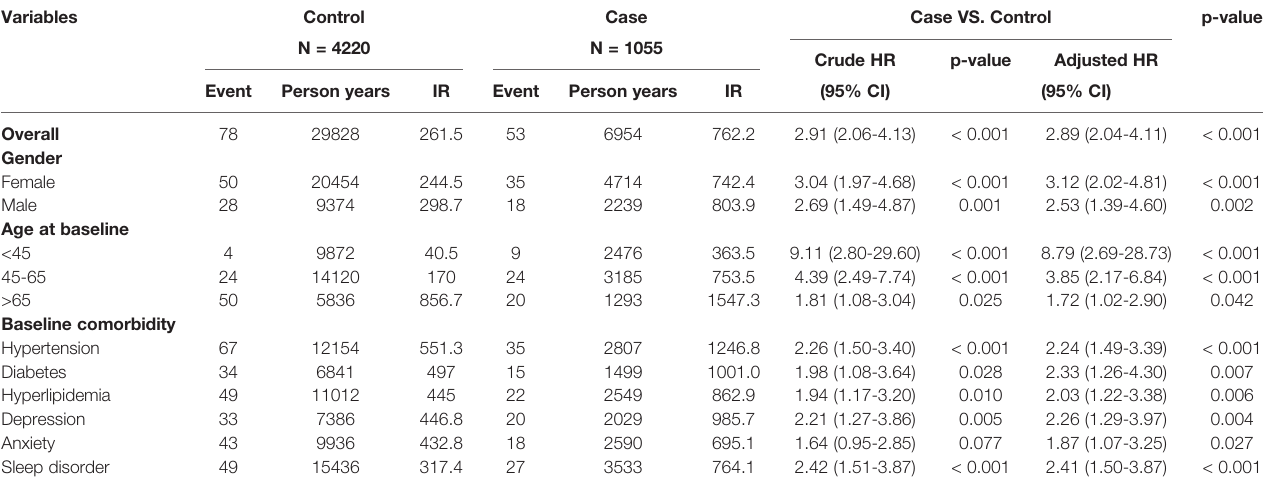
TABLE 3 | Incidence rates, hazard ratio and con fi dence intervals of parkinsonism in different strati fi cation. Variables Control Case Case VS. Control